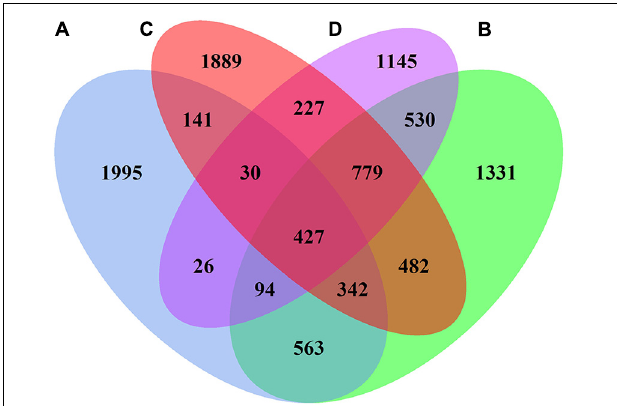
FIGURE 4 | Venn diagram displaying the number of shared bacterial OTUs between the soil samples collected at different sites.